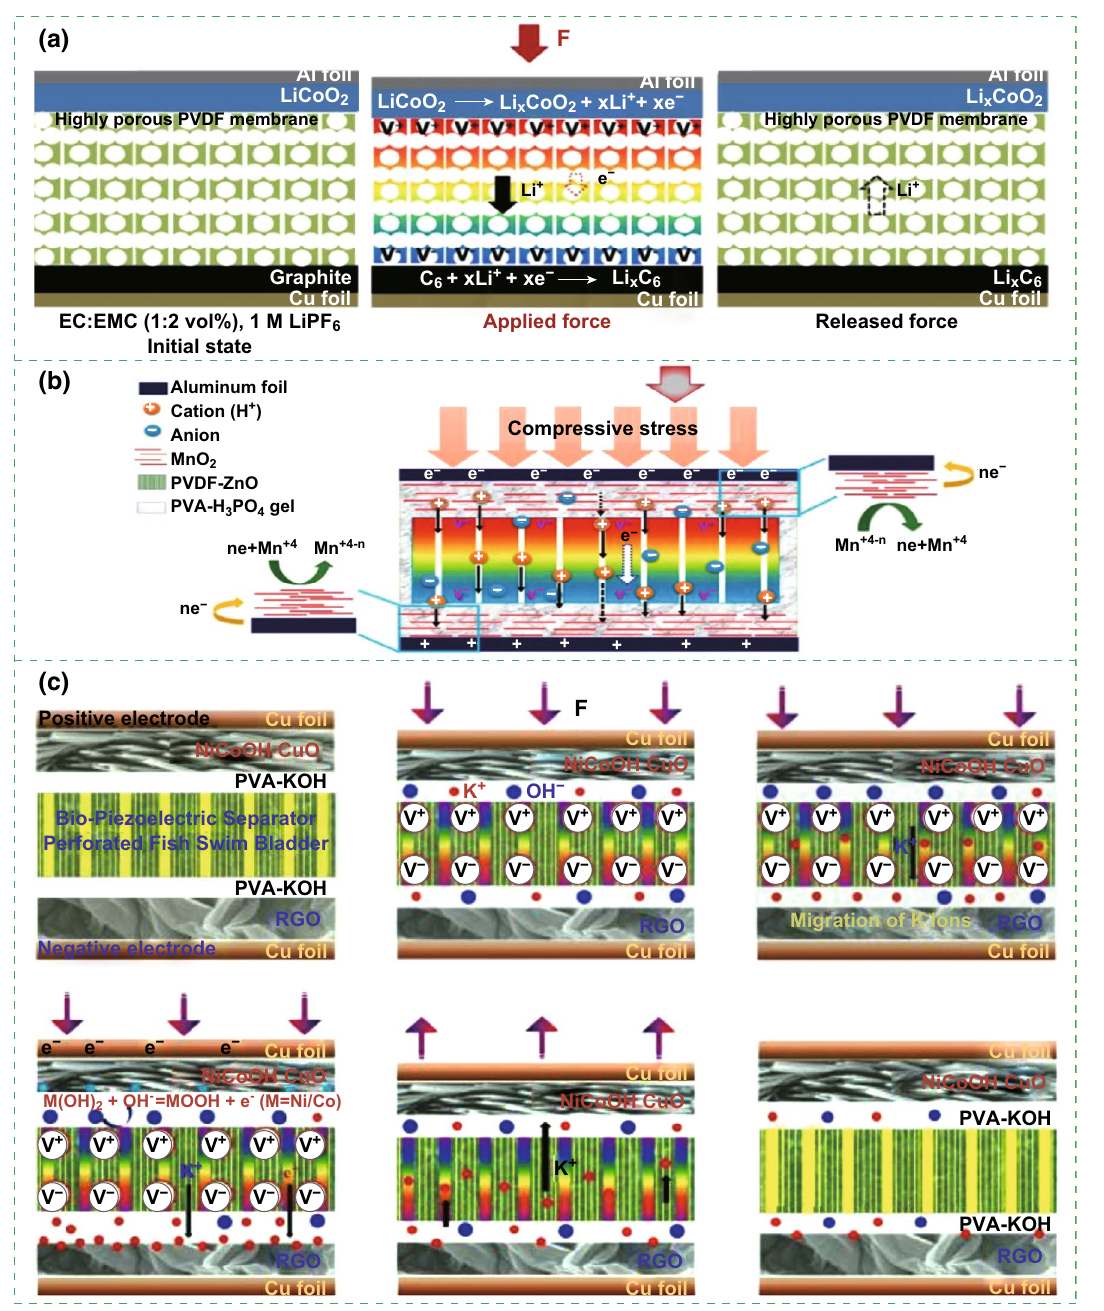
Fig. 7 a Schematic self‑charging mechanism induced by a porous PVDF piezo‑separator in Li‑ion secondary batteries. Reprinted with permis‑ sion from Ref. [13]. b Working mechanism of the SCSPC driven by mechanical deformation. Reprinted with permission from Ref. [17]. c Typi‑ cal working mechanism of the solid‑state SCASC under applied mechanical deformations. Reprinted with permission from Ref.